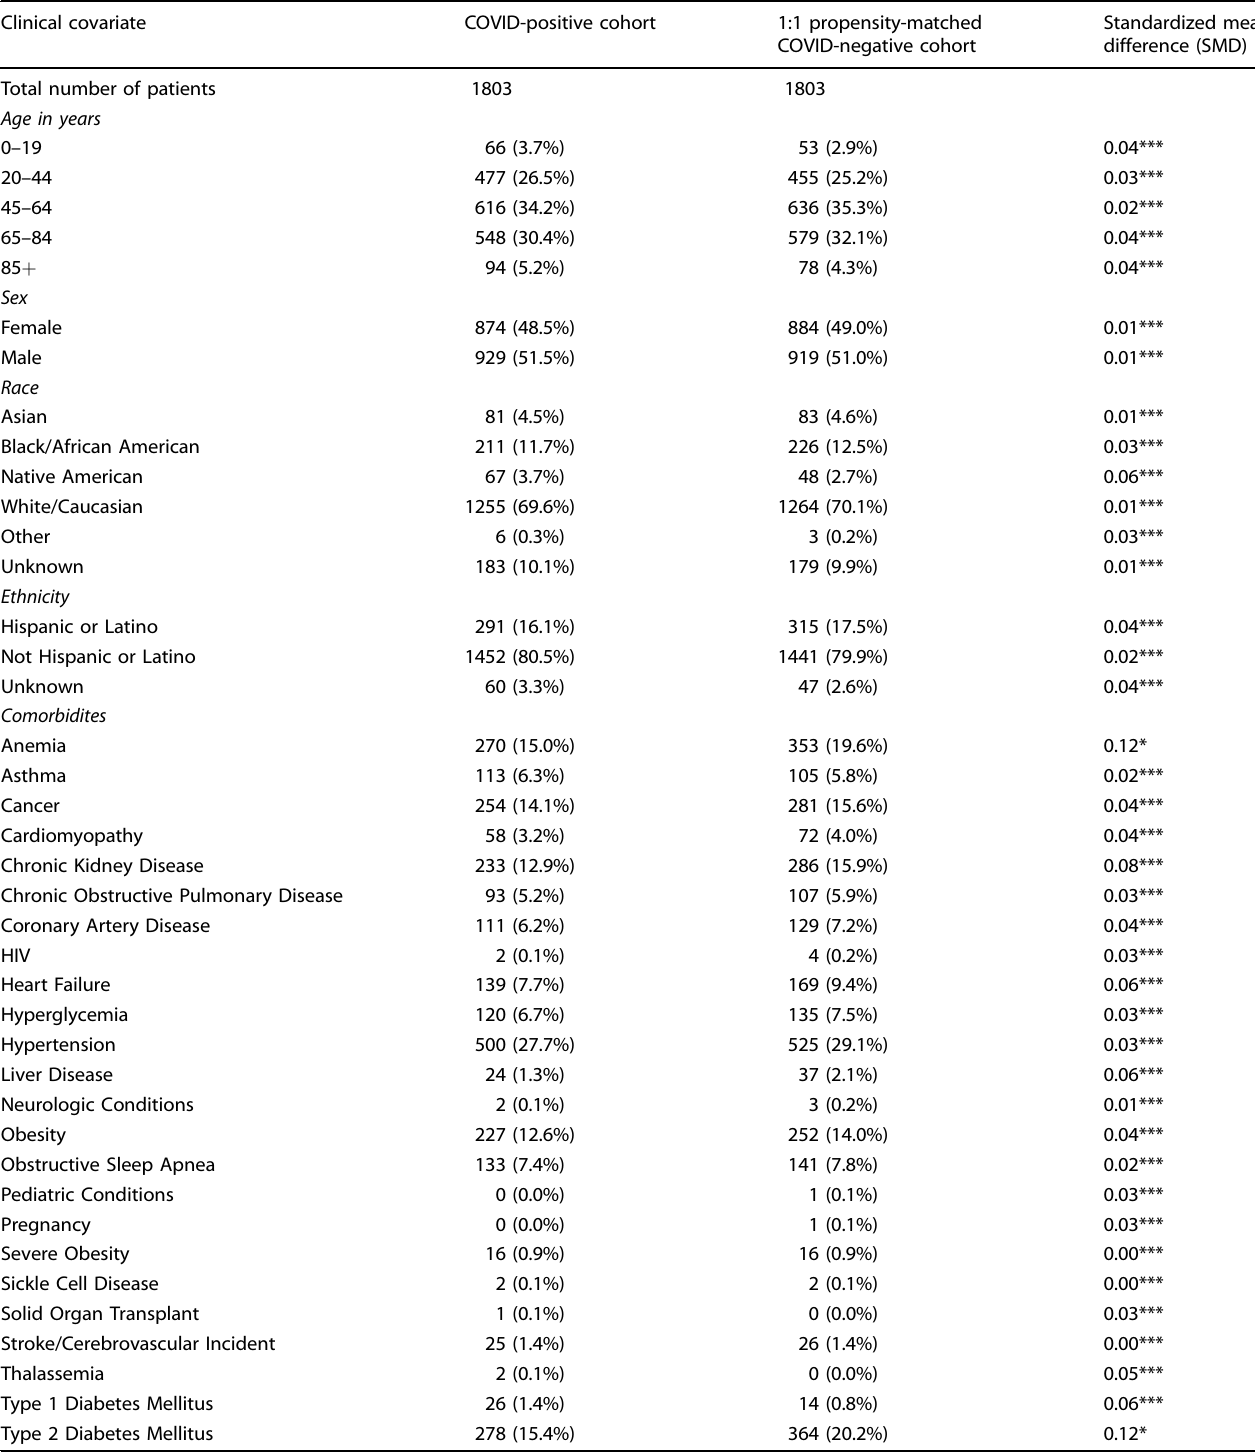
Table 3. Characteristics of COVID-positive and COVID-negative patients. Clinical